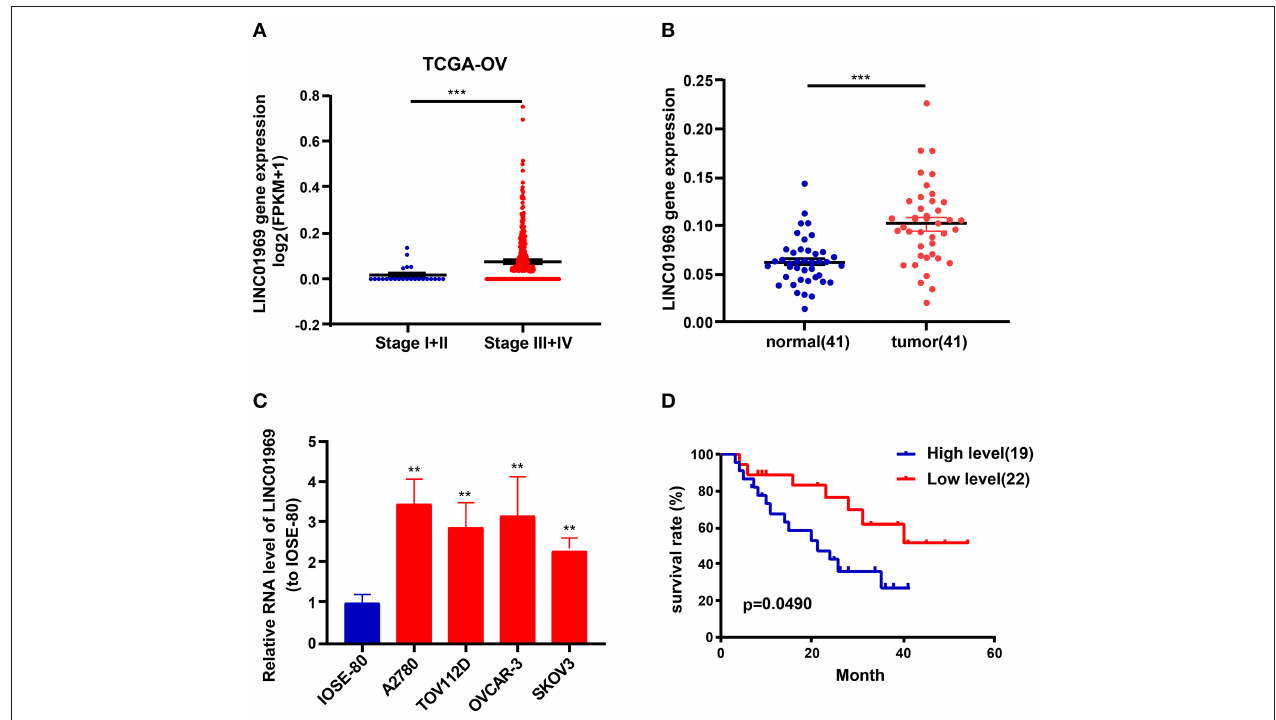
FIGURE 2 | LINC01969 expression is upregulated in ovarian cancer (OC) tissues and cell lines. (A) LINC01969 expression in OC stage I + II and stage III + IV from TCGA database. (B) Quantitative real-time PCR (qRT-PCR) results indicated that LINC01969 was upregulated in OC tissues ( n = 41) compared with paired non-normal tissues ( n = 41). (C) LINC01969 expression in OC cell lines and IOSE-80 cell line was analyzed by qRT-PCR. (D) Kaplan–Meier curves of overall survival (OS) in 41 OC patients based on LINC01969 level (average expression value was the cutoff). Data represent the mean ± SD; ** P < 0.01, *** P < 0.001.